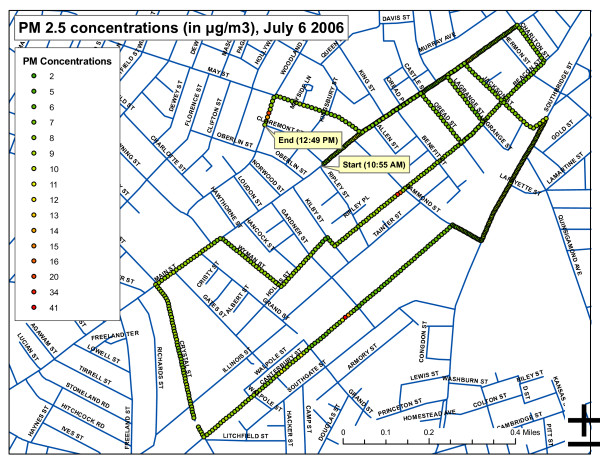
Map of PM2.5 levels on July 6, 2006 walk. Data was collected by synchronizing PM meter readings with a GPS unit.